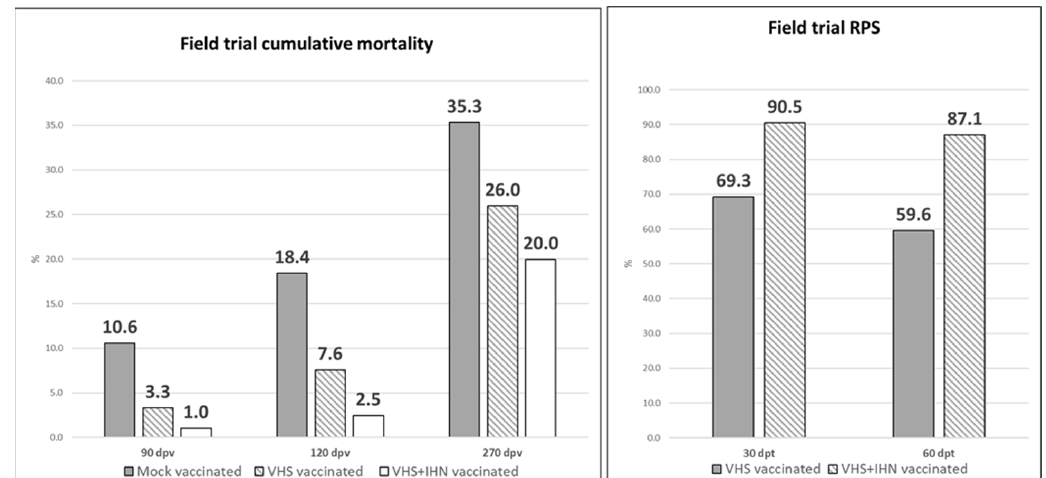
Figure 6. Field trial cumulative mortality and RPS at 90 and 120 dpv and cumulative mortality ob- served at 270 dpv. At each time, all the mortality values are statistically different ( p < 0.001).